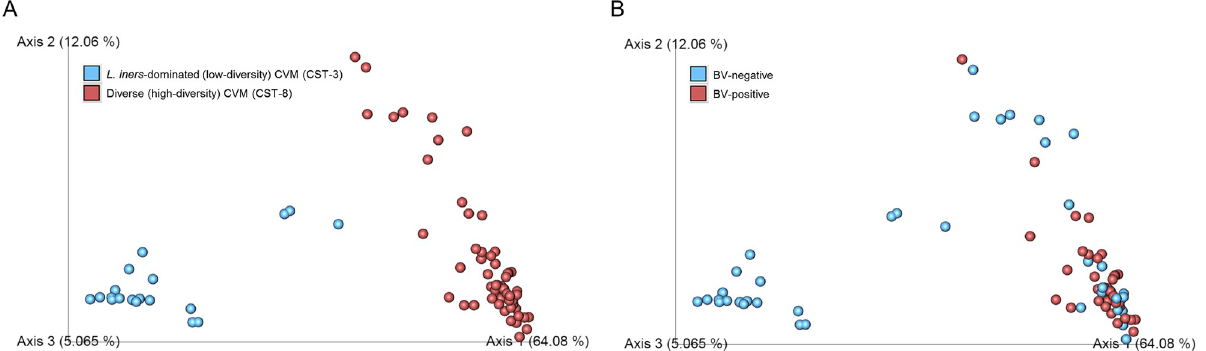
Fig 4. Beta diversity metric with principal component analysis (PCoA) clustering of the predicted metagenomic content. (A) PCoA according to community state type (CST, Maya blue: CST-3 and Indian red: CST-8). (B) PCoA according to BV status (Maya blue: BV-negative and Indian red: BV- positive). Each solid dot represents one cervicovaginal sample. The first three PCoA axes and the percentage variation explained by each indicated are shown (Axis 1: 64.08%, Axis 2: 12.06%, and Axis 3: 5.065%).